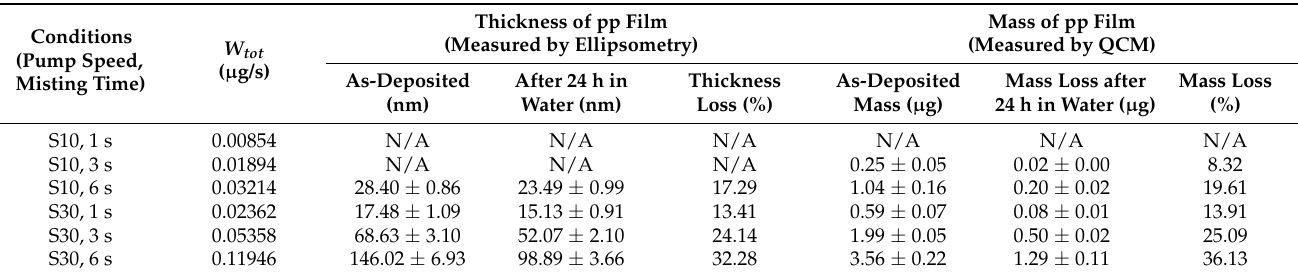
Table 2. Thickness and mass losses of pp films prepared with MC25 at different pump speeds and misting times, and 16 s plasma polymerization time.